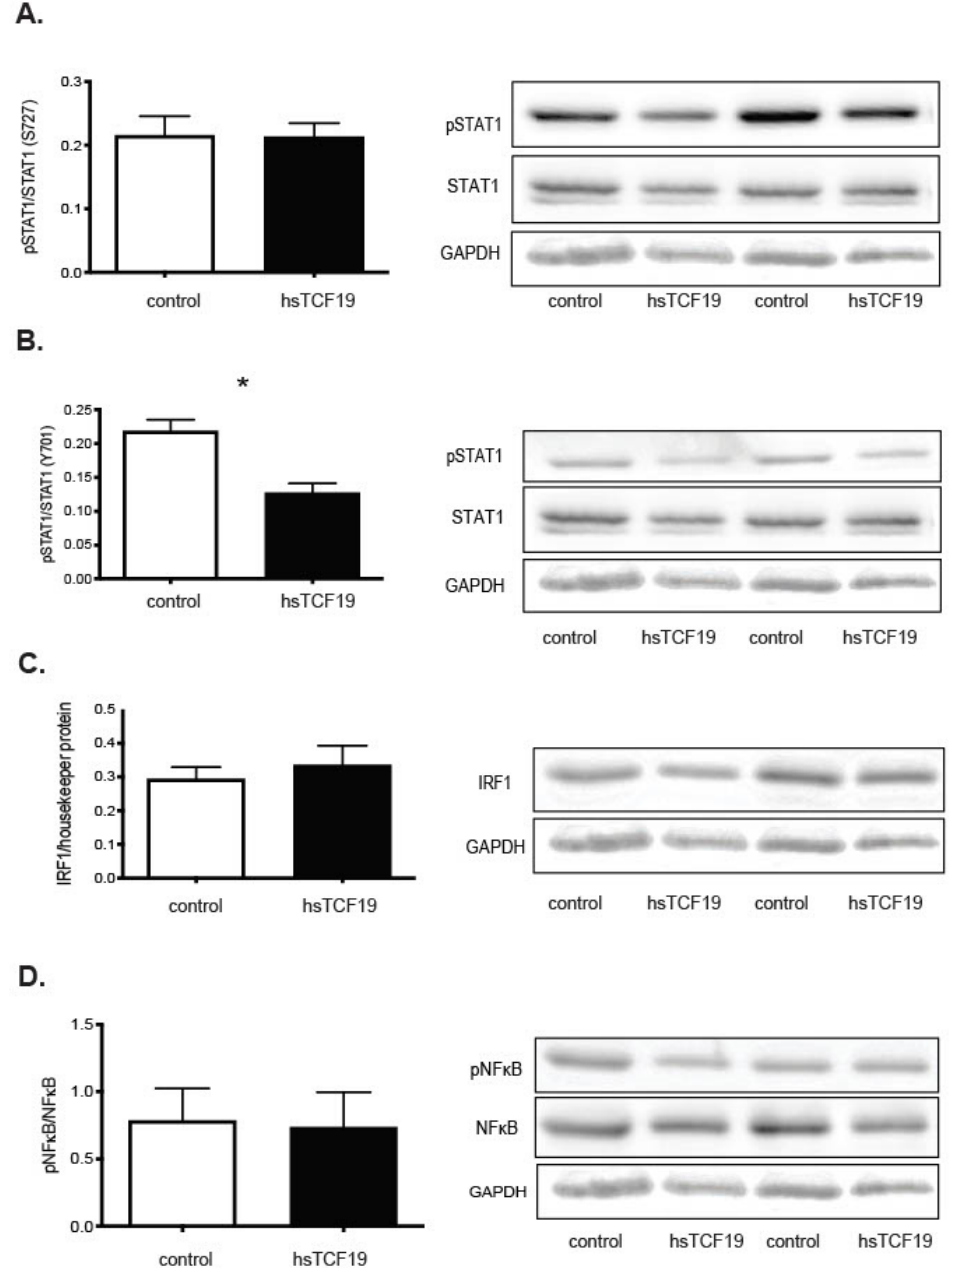
Figure 5. Overexpression of TCF19 in INS-1 cells does not lead to increased activation of transcription factor targets but leads to decreased activation of STAT1 Y701 phosphorylation. Representative images of two western blot replicates along with analysis of all replicates are shown. Densitometry with Image J 1.44o was used to quantify the bands on the western blots, which were then normalized to the housekeeper protein band. ( A ) Serine 727 phospho-STAT1/STAT1 protein expression does not show a statistically significant difference between control and hsTCF19 overexpressing cells (n = 5) (phospho-STAT1~91 kDa, STAT1~84, 91 kDa). ( B ) Tyrosine 701 phospho-STAT1/STAT1 protein expression shows statistically significant decrease in hsTCF19 overexpressing cells compared to control (n = 3) (phospho-STAT1~84, 91 kDa). ( C ) IRF1 protein levels are not significantly different. Representative western blots in the figure have IRF1 levels normalized to GAPDH. Three other replicates are normalized to beta tubulin (n = 5) (IRF1~48 kDa). ( D ) There is no difference in phospho NF- κ B/NF- κ B levels with hsTCF19 overexpression (n = 3) (phospho NF- κ B~65 kDa, NF- κ B~65 kDa). All data are means ± SEM * p <